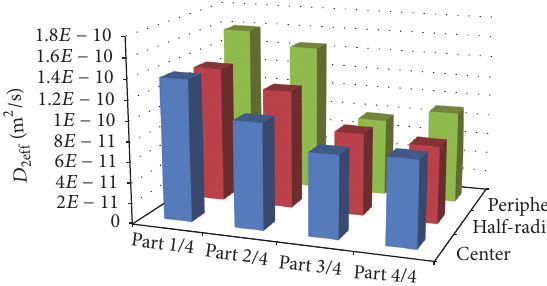
Figure 9: Distribution of the effective diffusion coefficient in the pith of Raffia vinifera in twelve sampling zone during the final